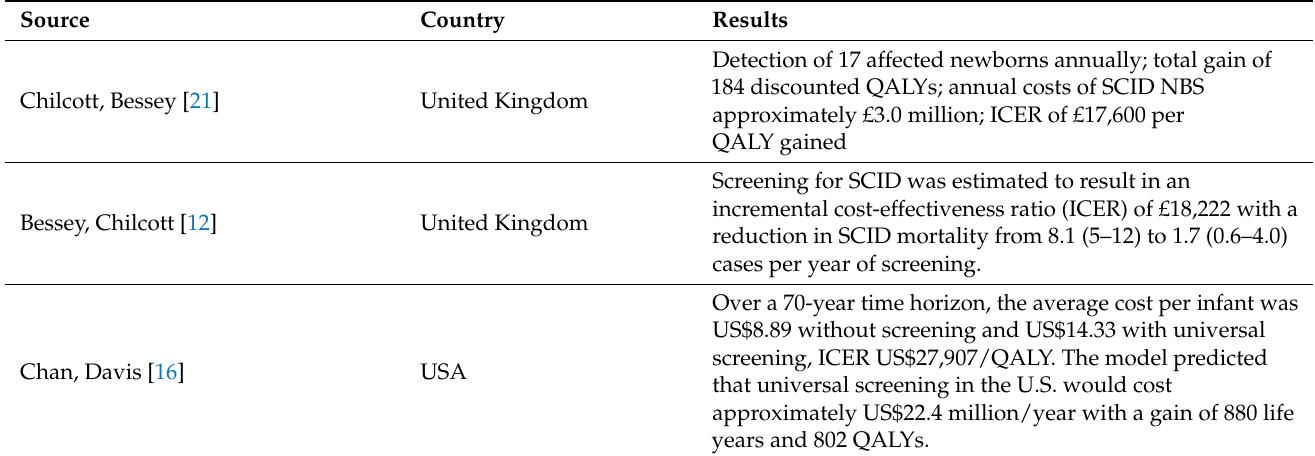
Table 1. Published cost-effectiveness analyses of newborn screening (NBS) for severe combined immunodeficiency